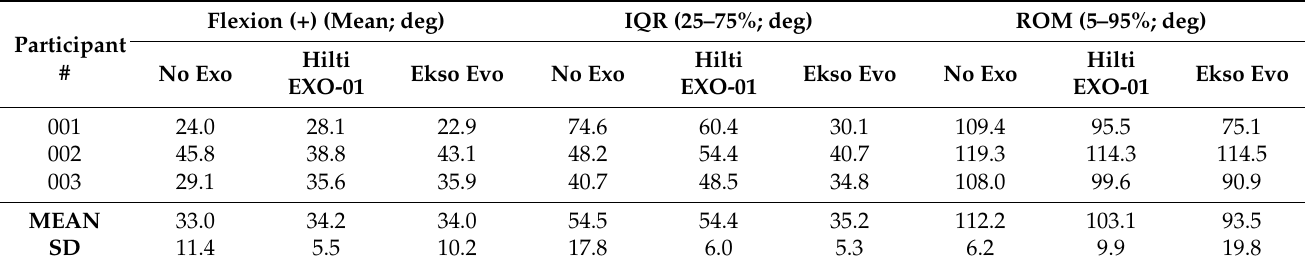
Table 6. Flexion/extension (deg) of the right shoulder.